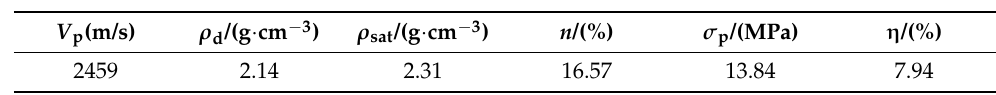
Figure 3. Experimental procedure and equipment. Table 1. The physical and mechanical parameters of selected samples.